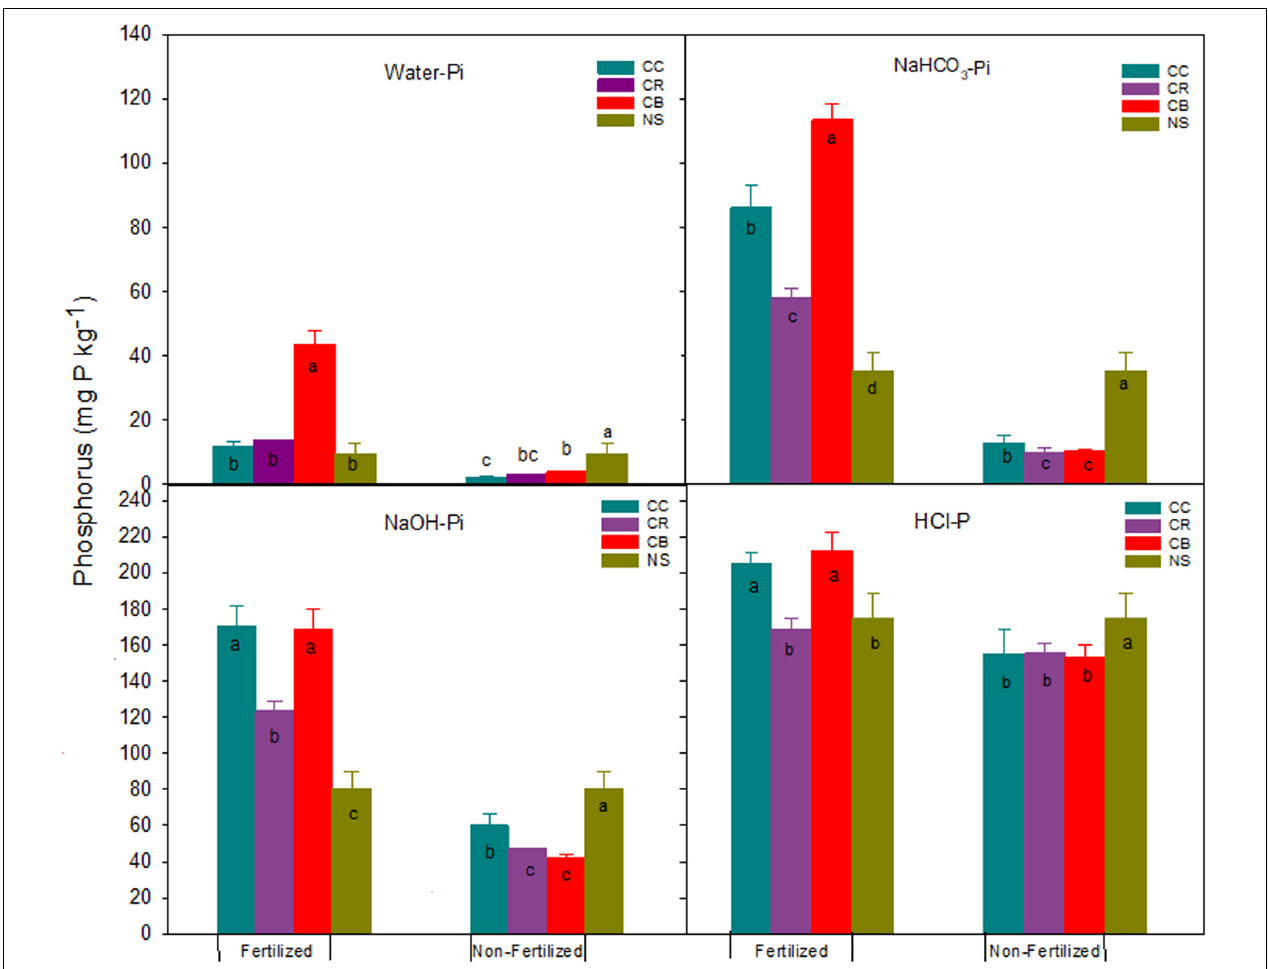
FIGURE 2 | Water-P i , NaHCO 3 -P i , NaOH-P i , HCl-P, and standard errors ( n = 3) (mg kg − 1 ) in a Brookston clay loam at Woodslee, ON, Canada, after 45-year consistent cropping with and without P fertilization relative to its native forest soil (NS). CC, continuous corn; CB, continuous bluegrass sod; CR, corn-oats-alfalfa-alfalfa rotation. Letters in or above the bars are significant levels (at P ≤ 0.05) with LSD test conducted separately for the fertilized and non-fertilized